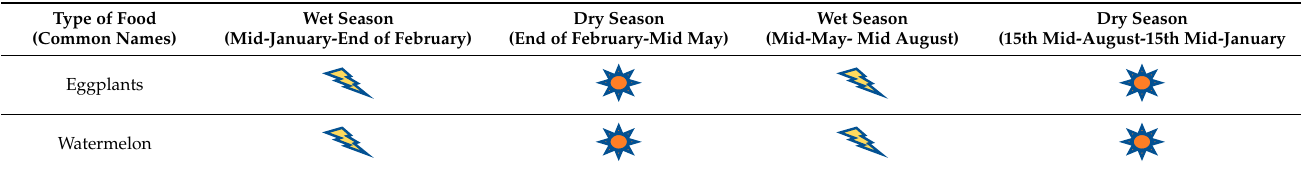
Table 4. Seasonal calendar with the most eaten crops, fruits and vegetables according to the Batwa and Bakiga participants. Lightening (wet season) and sun (dry season) icons indicate when the food items are harvested and eaten.